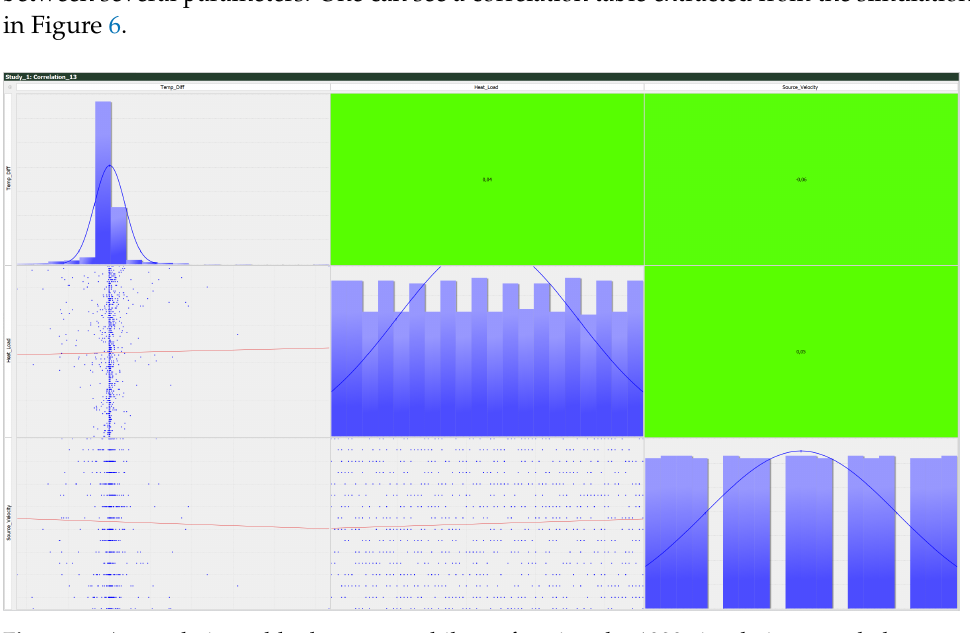
Figure 6. A correlation table drawn up while performing the 1000 simulations needed to create the response surface. The chosen parameters are placed on the x- and y-axis in order to get a relation between the parameters separately. The connections represented in the table are solely linearly approached, resulting in non-accurate approximations. The colour of each box gives a visual representation of the correlation between the parameters. One should inspect the dispersion of the measurement points for one parameter in order to find the correlation as the linearly approximation is faulty. This visualisation focuses on the influence of the heating power in combination with the source velocity in order to predict the resulting temperature difference. A correlation table can be drawn for every parameter combination as